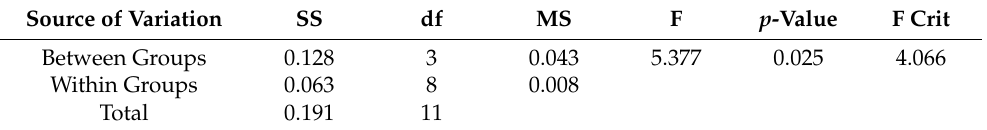
Table 4. One-factor ANOVA for effect of treatment on bulk densisty ( p = 0.05). Source of Variation SS df MS F Between